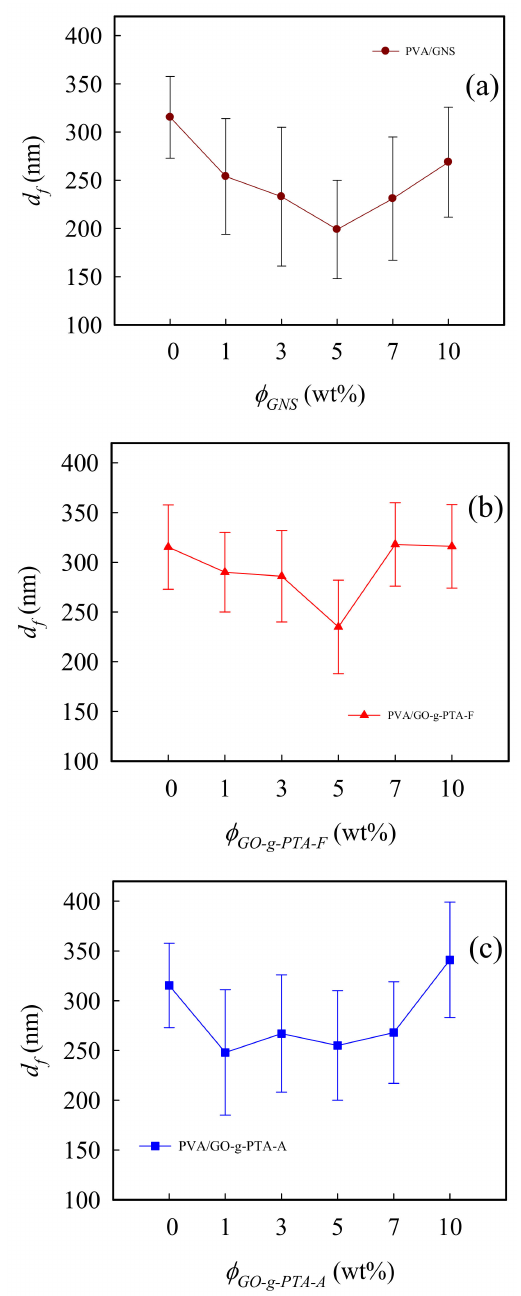
Figure 8. Fiber diameter versus filler content of the ( a ) PVA / GNS, ( b ) PVA / GO-g-PTA-F, and ( c ) PVA / GO-g-PTA-A composite